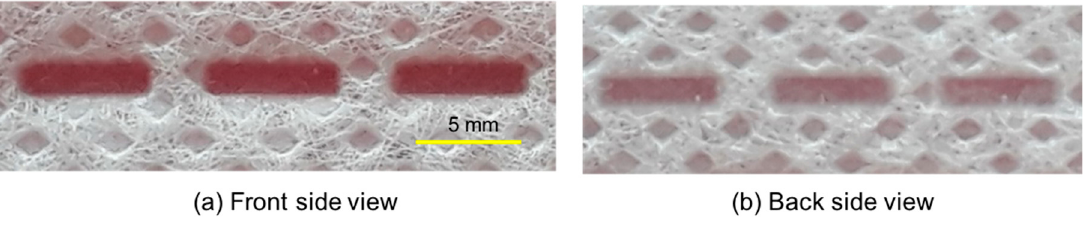
Figure 7. Nonwoven fabric after ultrasonic welding of No. 1 case. ( a ) Front side view, ( b ) Back side view.